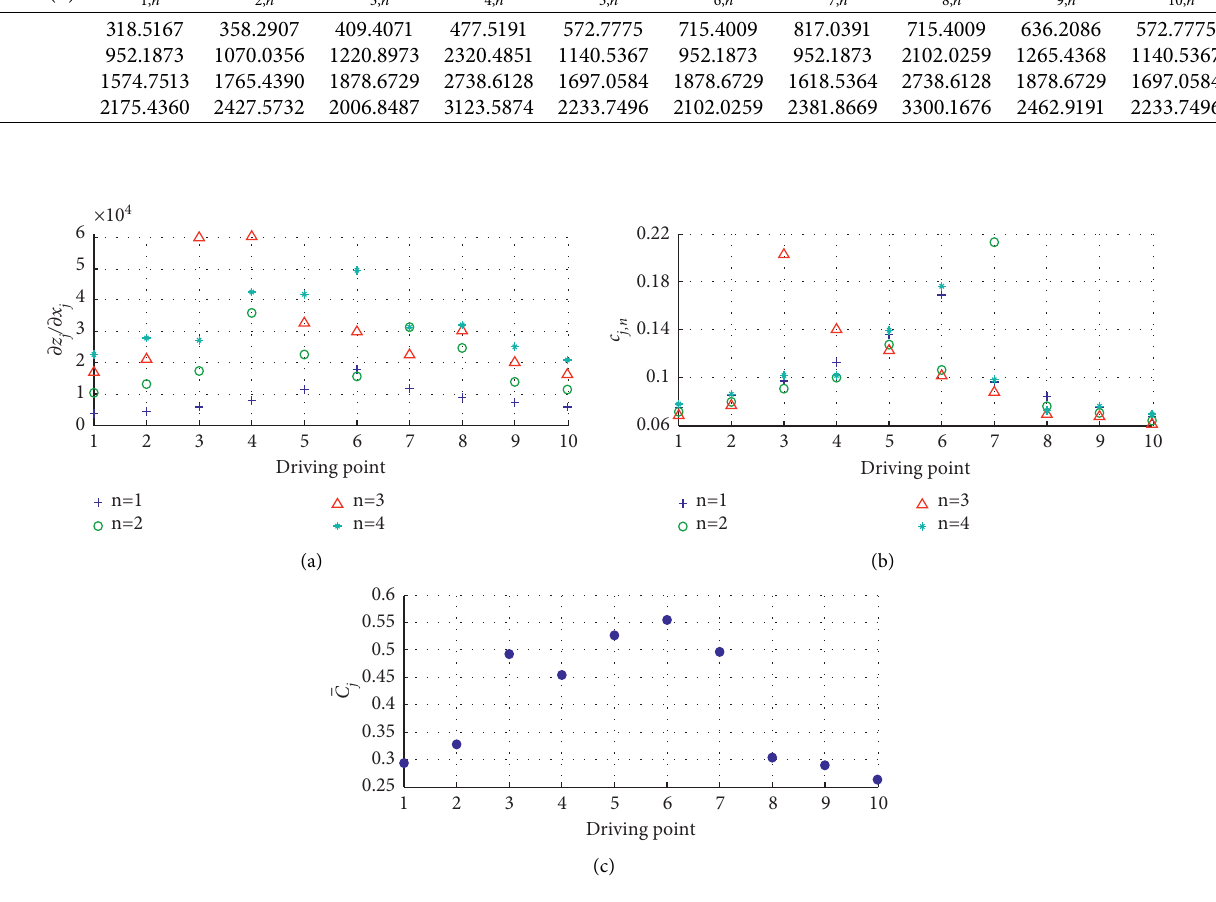
z x ( j � 1 , 2 , ... , N ; n � 1 , 2 , . .. , N ) for N � 4 and N � 10. (b) The normalised sensitivity j,n / j P m m P